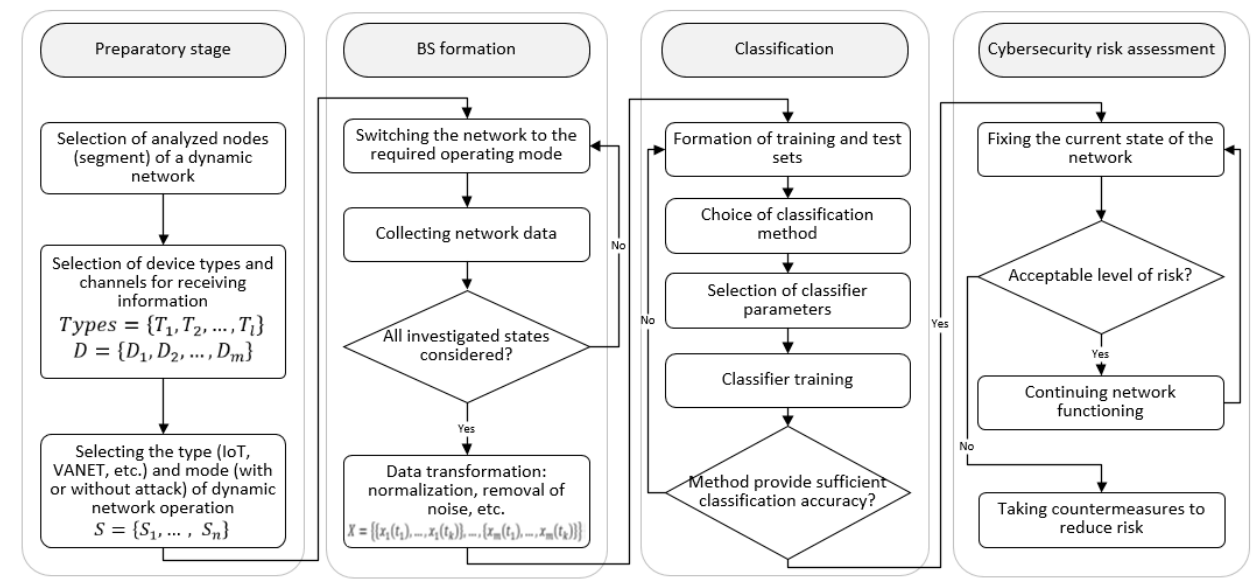
Figure 12. The proposed methodology for the cybersecurity risk assessment.